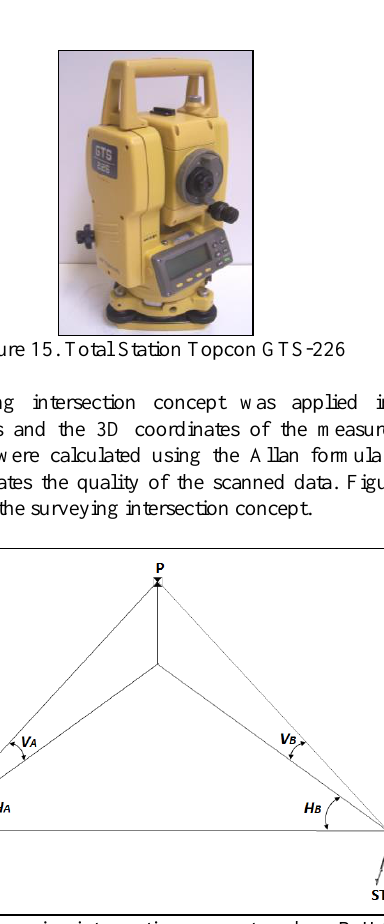
Figure 16. Surveying intersection concept – where P, HA and HB, and VA and VB are the measurement target, horizontal angles and vertical angles, respectively (source: Zulkarnaini,